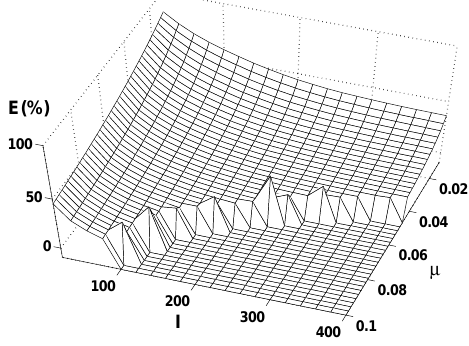
Fig. 12. LMS global errors E of the identified models, case ( C 3 ).